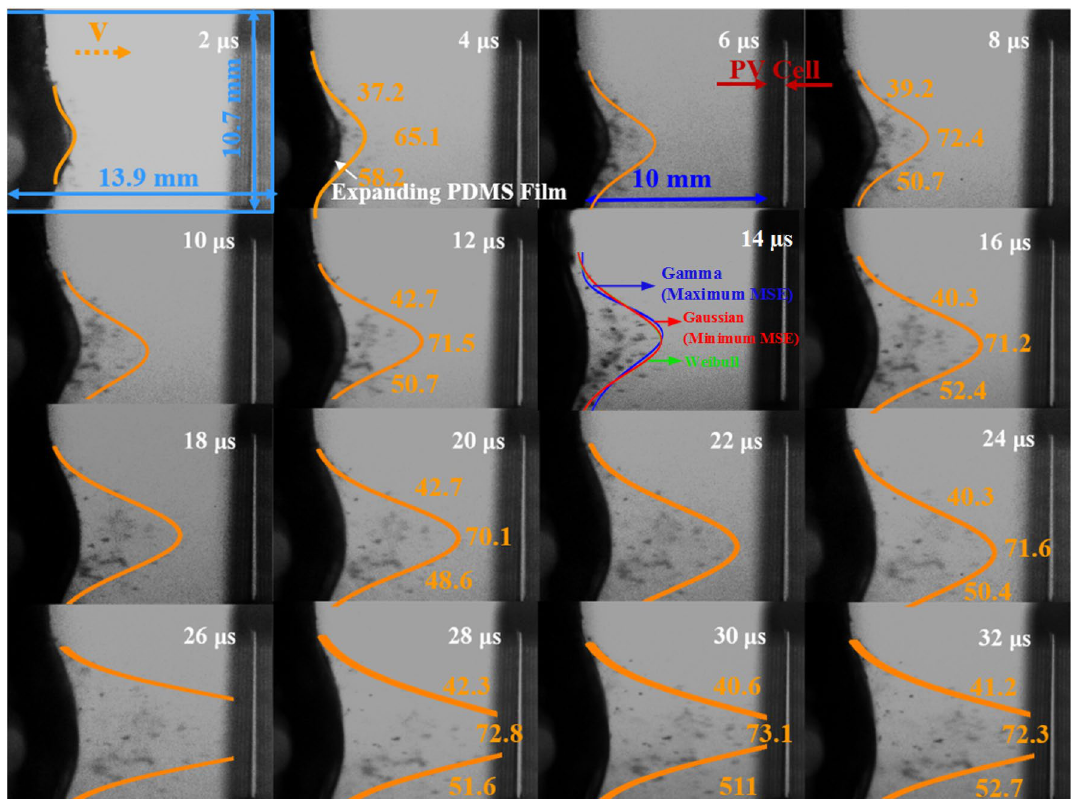
Figure 1. Impact history of particles on the PV cell. It is clearly shown that the radial distribution of velocities of the particles is nearly in Gaussian distribution (The unit for velocities: m/s).